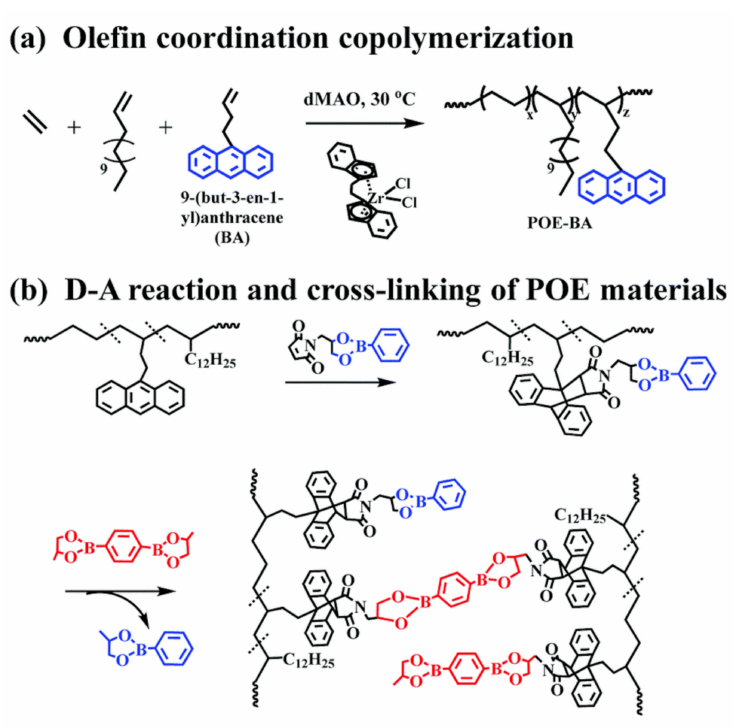
Figure 4. ( a ) The ternary copolymerization of ethylene, C14, and BA comonomers. ( b ) Synthesis of dynamic cross-linked POE materials. Republished with permission of Royal Society of Chemistry, from reference [83] Copyright (2020); permission conveyed through Copyright Clearance Center,